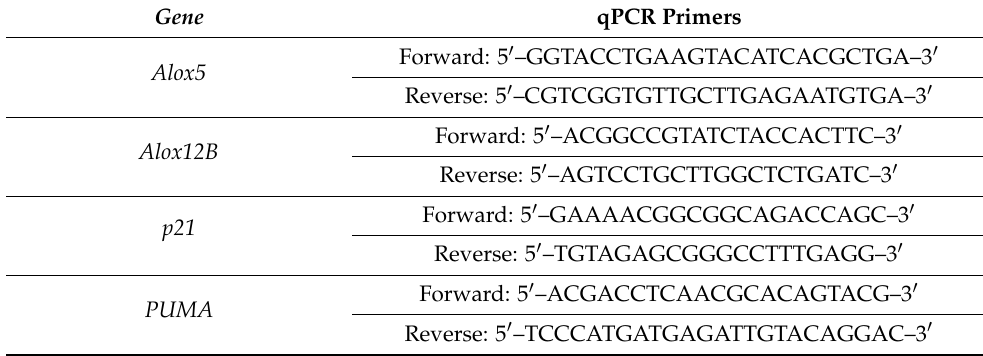
Table 1. The specific primer